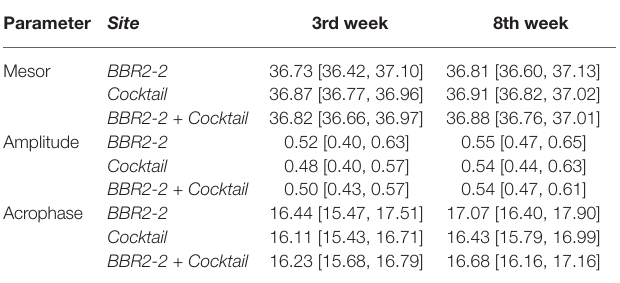
Circadian parameters were determined by cosinor analysis with a 24-h cycle. Data were collected during the 3rd and the 8th week of two HDBR studies (BBR2-2: n = 5, Cocktail: n = 8). Data are means and their nonparametric bootstrapped 95% CIs.